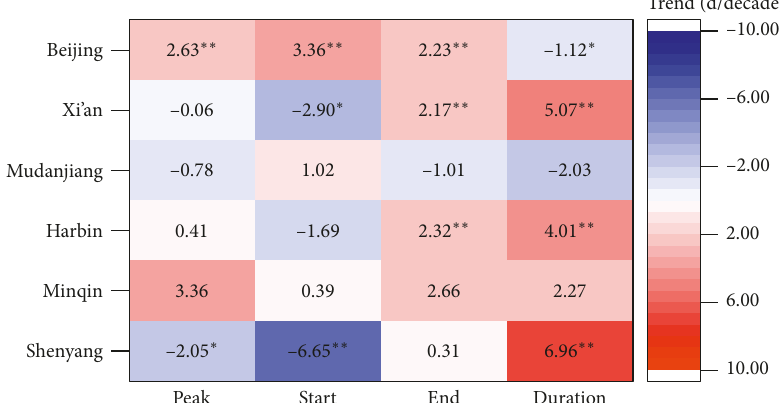
Figure 6: Trends of the peak, start, end, and duration of the leaf coloring season at six sites. Plus shows delay, and minus shows